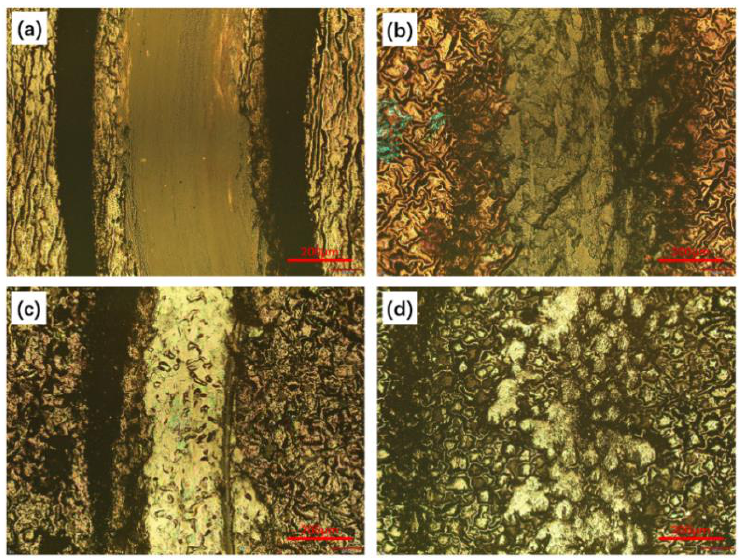
Figure 11. Optical images of the wear tracks of the DLC films prepared on Ti/PMMA at a different substrate bias of ( a ) 350 V, ( b ) 550 V, ( c ) 750 V, and ( d ) 950 V with conductive materials.